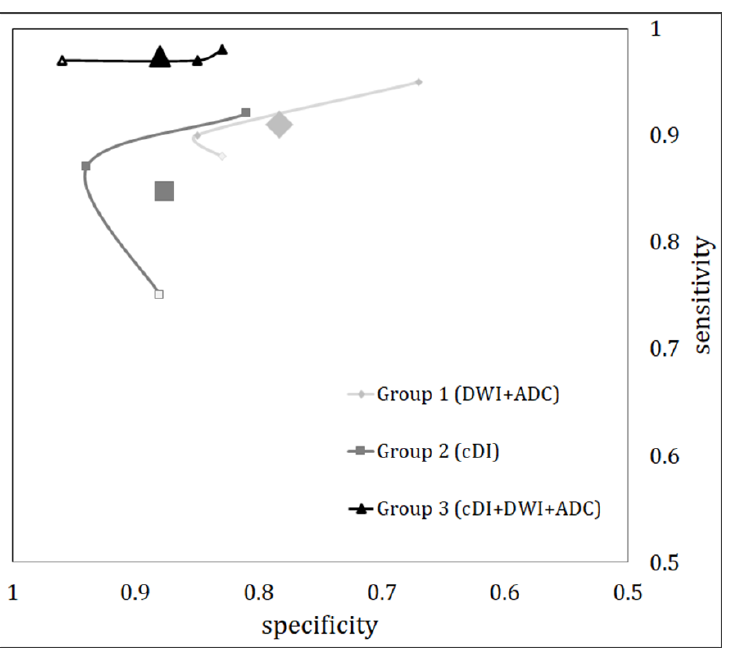
Figure 5. Diagnostic accuracy of the three distinct groups. The sensitivity ( y -axis) and specificity ( x -axis) for the three readers are plotted for the reading DWI (light gray diamond), mcDI (dark gray square), and the combined image information (black triangle). The results of the three readers are connected for visibility. The larger icon represents the mean values for all readers. Reader 1 (transparent icons) had the lowest sensitivity for identifying PCa from DWI and mcDI separately. However, his sensitivity and specificity were most improved from the combination of the two sequences. Reader 2 (middle icon) improved his specificity for reading the mcDI; however, his sensitivity decreased slightly. The combination of the DWI and mcDI improved his sensitivity without losing the specificity. Reader 3 (dark outer icon) had the highest sensitivity in all his reads. He improved his sensitivity and specificity with the combination of the two